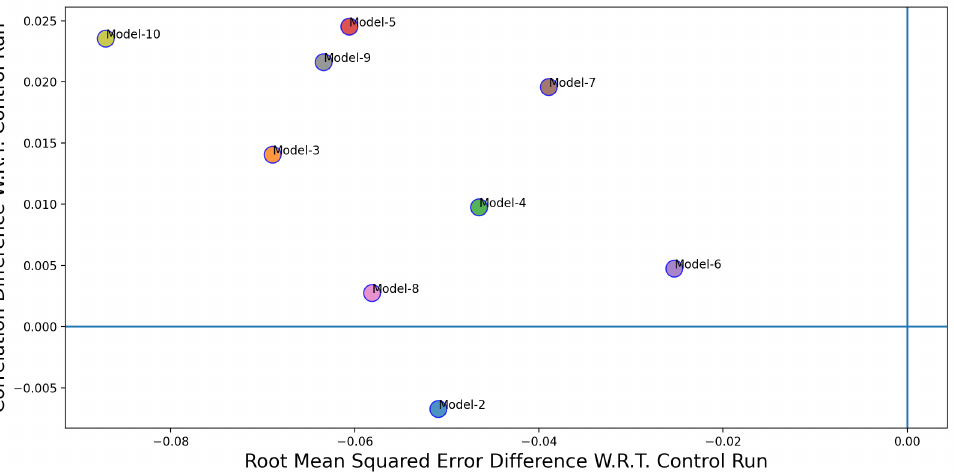
Figure 10. Improvement over control run for Generalized Linear Model. The x-axis represents the difference between the RMSE values for the control run and the Twitter-based models. The y-axis represents the difference between the correlation coefficient values between the control run and the Twitter based